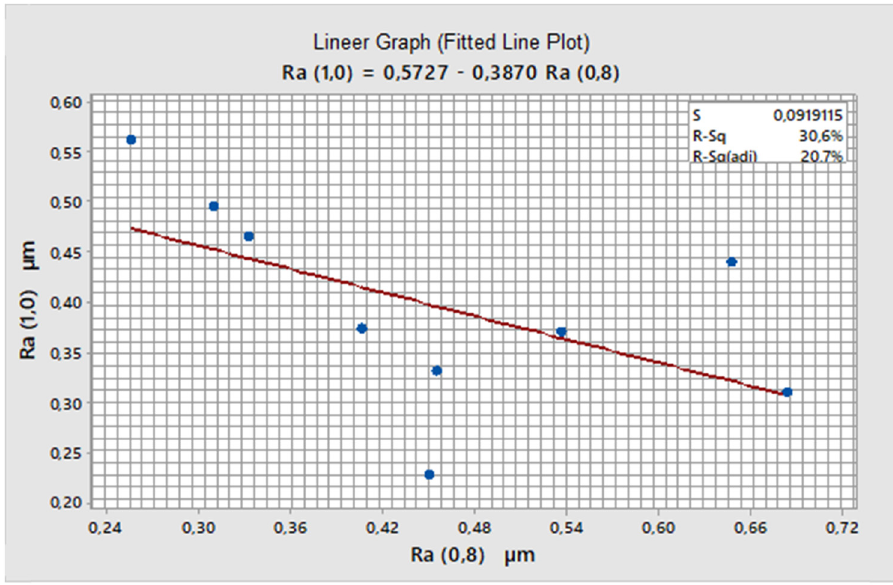
Figure 4: Comparison of surface